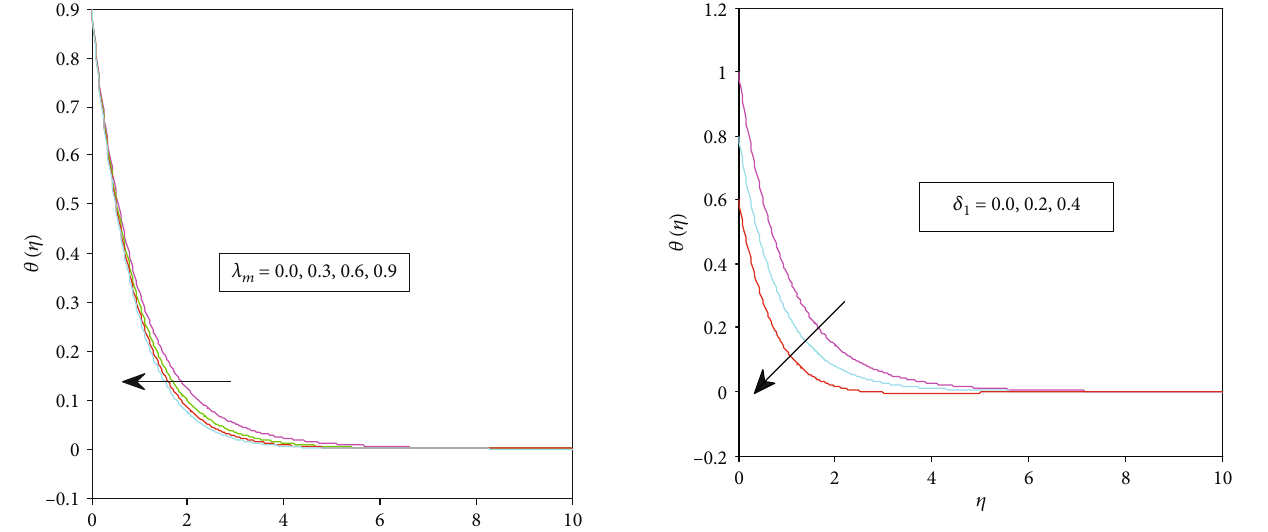
Figure 10: Temperature distribution for di ff erent values of the thermal strati fi cation parameter.